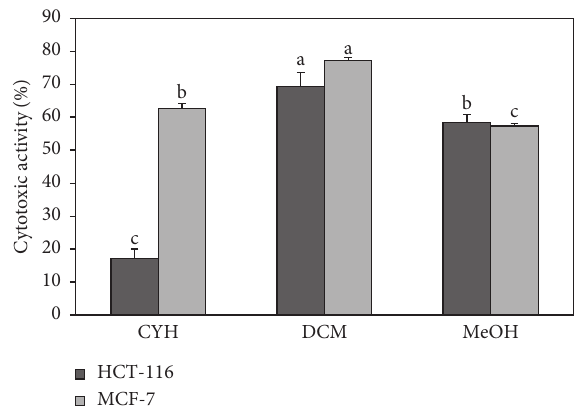
Figure 2: Cytotoxic activity of R. crispus extracts on MCF-7 and HCT-116 cancer cell lines. (CYH: cyclohexane; DCM: dichloro- methane; MeOH: methanol). Data are the mean of three repeti- tions ± SD. Different letters indicate significant differences according to Tukey test ( p ≤ 0 . 05).